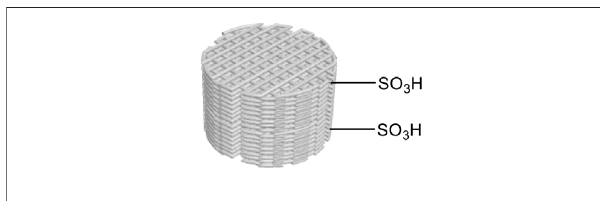
SCHEME 1 | 3D SiO 2 -SO 3